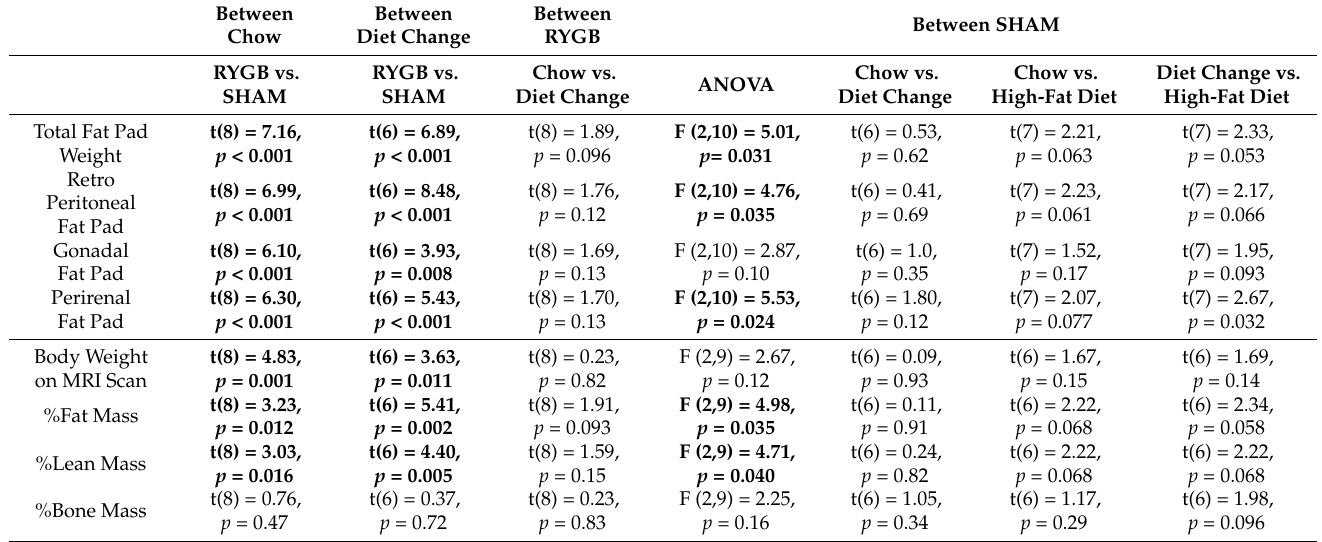
Table 5. Statistical analysis comparing body composition measures. For paired comparisons, un- corrected p -values are depicted; those that survived Bonferroni corrections are bolded . ANOVA analyses compared the overall effect of diet on the body composition measures between SHAM groups. Significant ANOVAs are also bolded